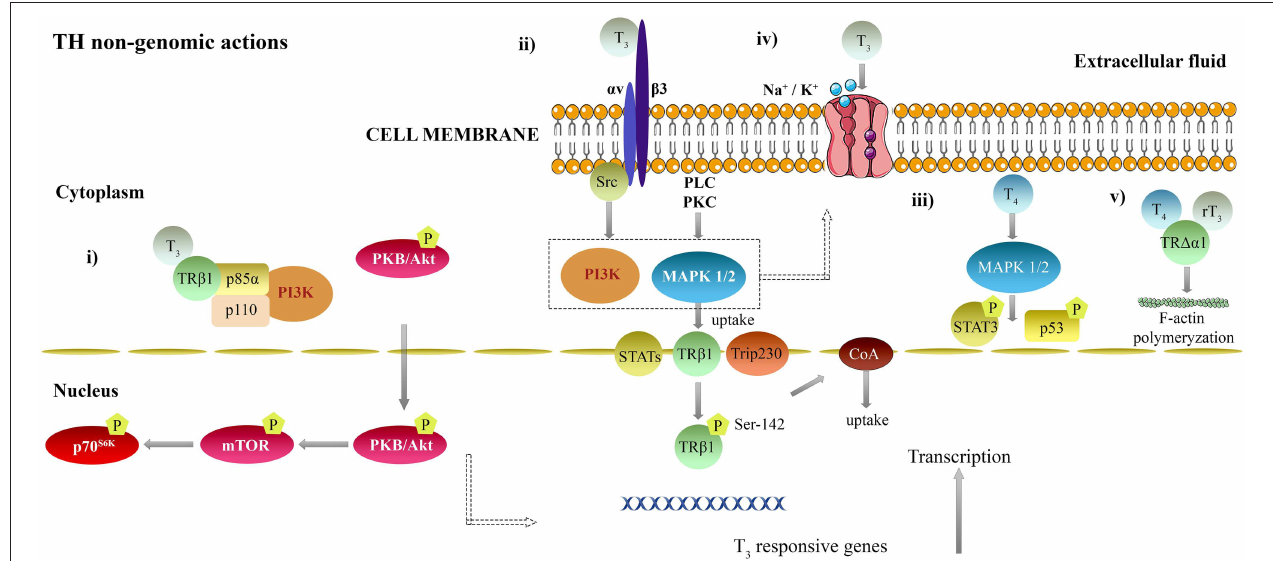
FIGURE 2 | Non-genomic mechanisms of thyroid hormones action in the brain. T 3 can also modulate other genes not containing TRE, by non-genomic actions. (i) T 3 complexed to TR β 1 in the cytoplasm interacts with p85 α subunit of PI3K, resulting in phosphorylation and activation of PKB/Akt signal transduction pathway, mTOR and phosphorylation of p70 S6K ( 131–136). (ii) T 3 is able to bind to integrin α v β 3 S1 domain in plasma membranes and activates PI3K via Src kinase. T 4 and T 3 interact with integrin α v β 3 S2 domain and activate MAPK 1/2 signaling cascade, PLC and PKC (127, 133, 137–140). Subsequently, it results in an nuclear translocation of TR β 1 (141), estrogen receptor α (142), STAT1 α , IFN- γ (143) and CoA protein Trip230 (144). In addition, hormone activated MAPK 1/2 phosphorylates TR β 1 at Ser-142, leading to recruitment of CoA proteins ( 145). (iii) T 4 non-gnomically activates MAPK 1/2 in HeLa and CV-1 cultured cells (146, 147) and phosphorylation of p53 (148) and STAT3 (147). (iv) T 3 modulates Na + /H + exchanger in myoblasts (149); Na-K-ATPase activity in alveolar epithelial cells (150–152), embryonal hepatocytes ( 153) and synaptosomes (154, 155) through either the PI3K or MAPK pathways (152, 156) the Ca-ATPase activity in erythrocytes (88), the sarcoplasmic reticulum in the heart ( 157) and in cerebrocortical synaptosomes (158). (v) T 4 and rT 3 stimulate polymerization of actin components of the cytoskeleton neuronal and astrocyte cell cultures, through TH binding to an extranuclear truncated form of TR α 1 (TR 1 α 1) (159–162). IFN- γ , interferon gamma; MAPK 1/2, mitogen-activated protein kinase 1/2; PLC, phospholipase C; PI3K, phosphatidylinositol 3-kinase; PK - protein kinase; mTOR – rapamycin; STAT - signal transducing and activator of transcription; TH, Thyroid hormones; TR, Thyroid hormone receptor; TRE, Thyroid response element; T 4 , 3,5,3 ′ ,5 ′ -tetraiodo-L-thyronine; T 3 , 3,5,3 ′